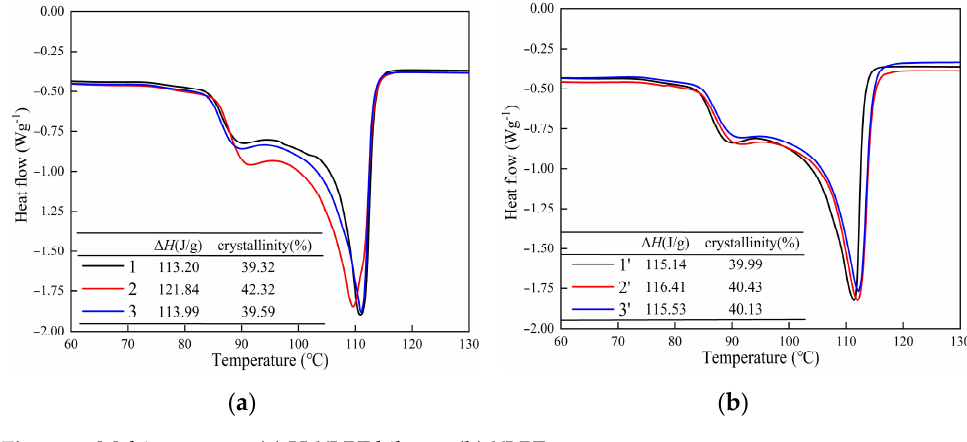
Figure 8. Melting curves, ( a ) H-XLPE bilayer; ( b ) XLPE. Table 2. Surface free energy of the various positions of H-XLPE bilayer and XPLE (unit: 10 − 3 J/m 2 ).